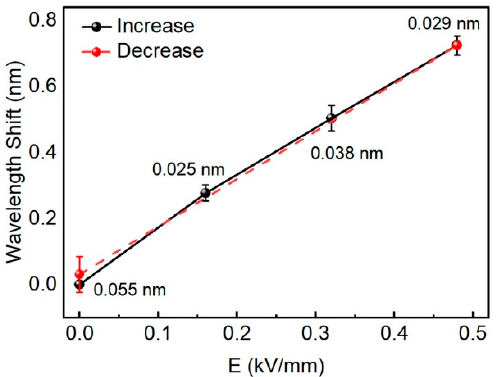
Figure 4. Wavelength tuning of the microring lasers under different electric fields.